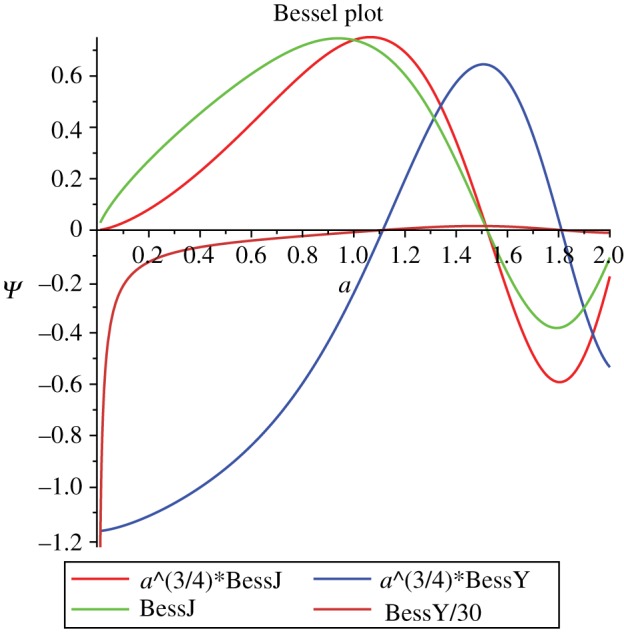
Bessel functions for a, σ=5ℏ/(6(6)).